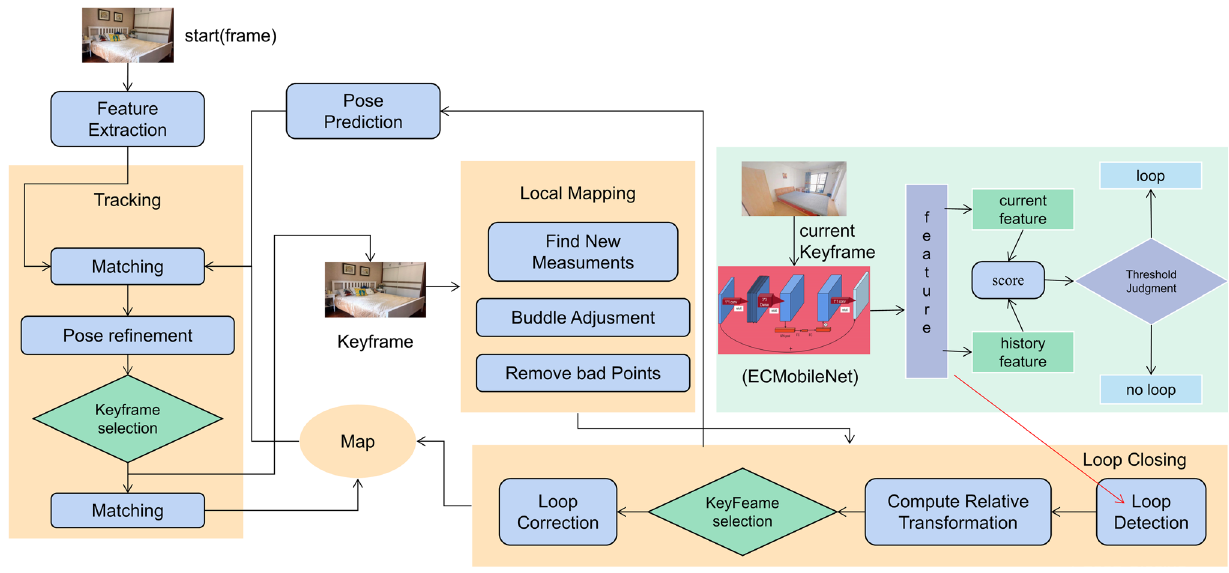
Fig. 6 In this image is the entire SLAM system including tracking, local mapping, and loop closure detection